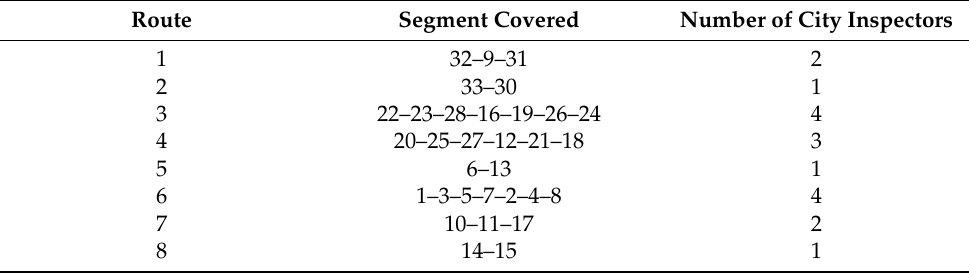
Table 6. The path patrol scheme of the improved algorithm.